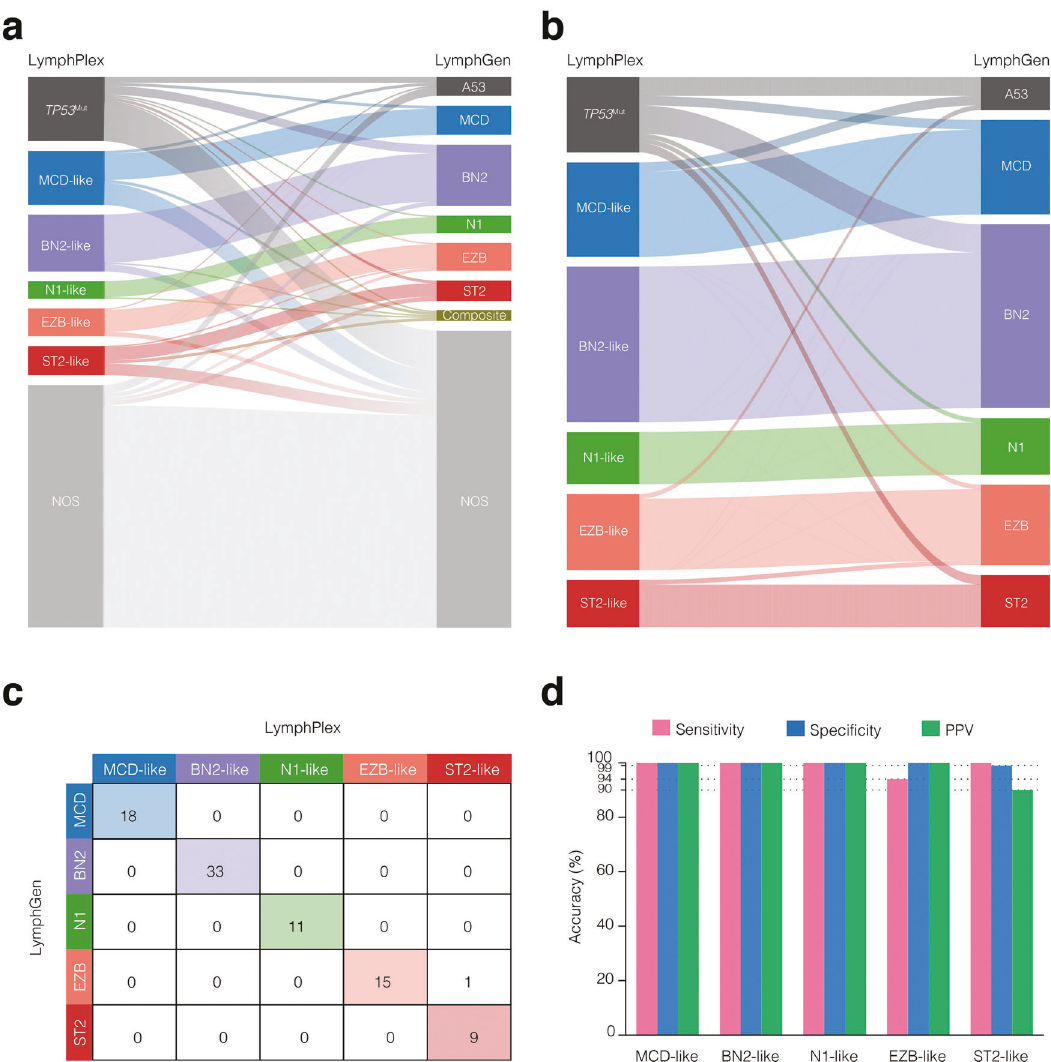
Fig. 2 Comparison of the LymphPlex and LymphGen algorithms. a Sankey plots showing comparison of the LymphPlex and the LymphGen algorithms in the 337 patients with WES/WGS data including copy number data in the Ruijin cohort or b in the 106 cases for whom a unique genetic subtype was assigned by both algorithms. c Confusion matrixes showing numbers of cases for each subtype assigned by LymphPlex and LymphGen. d Sensitivity, speci fi city, and precision (positive predictive value (PPV)) of the LymphPlex algorithm for the subtype assignments, as compared to the assignments using the LymphGen